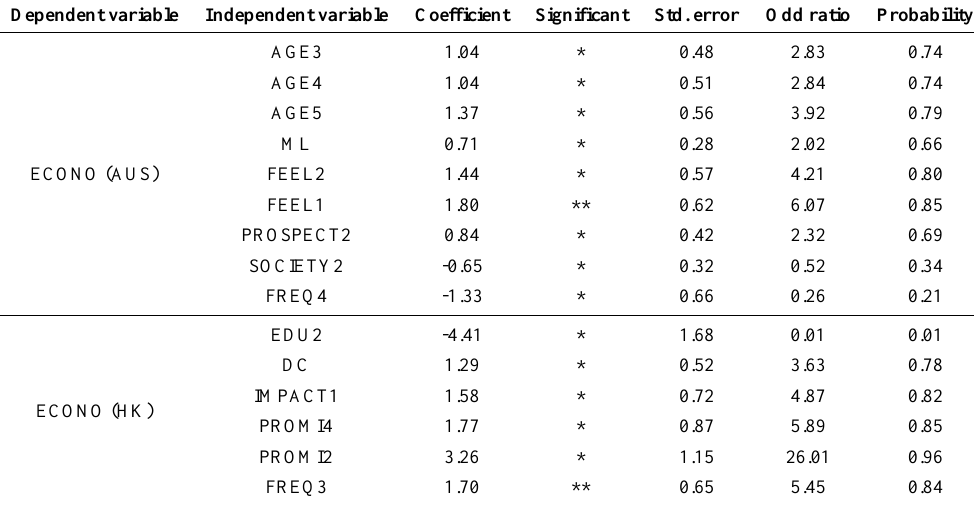
Table A-7. Economic